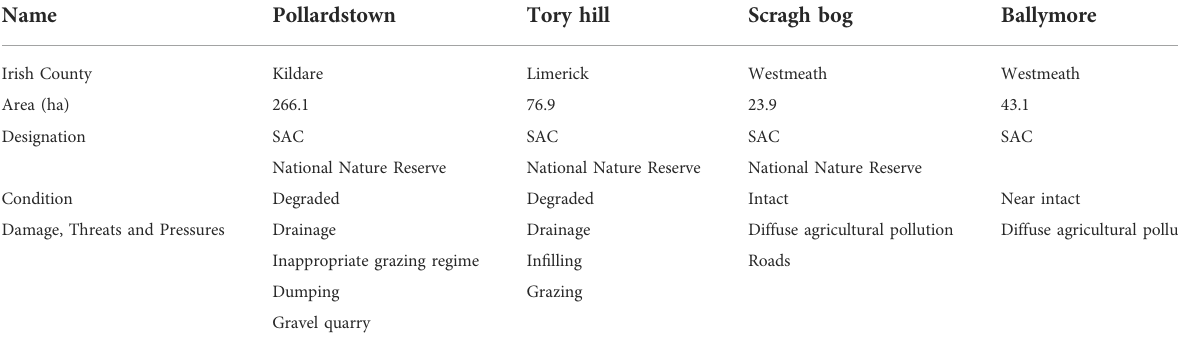
TABLE 1 Site speci fi cs for the four fens chosen for detailed study.